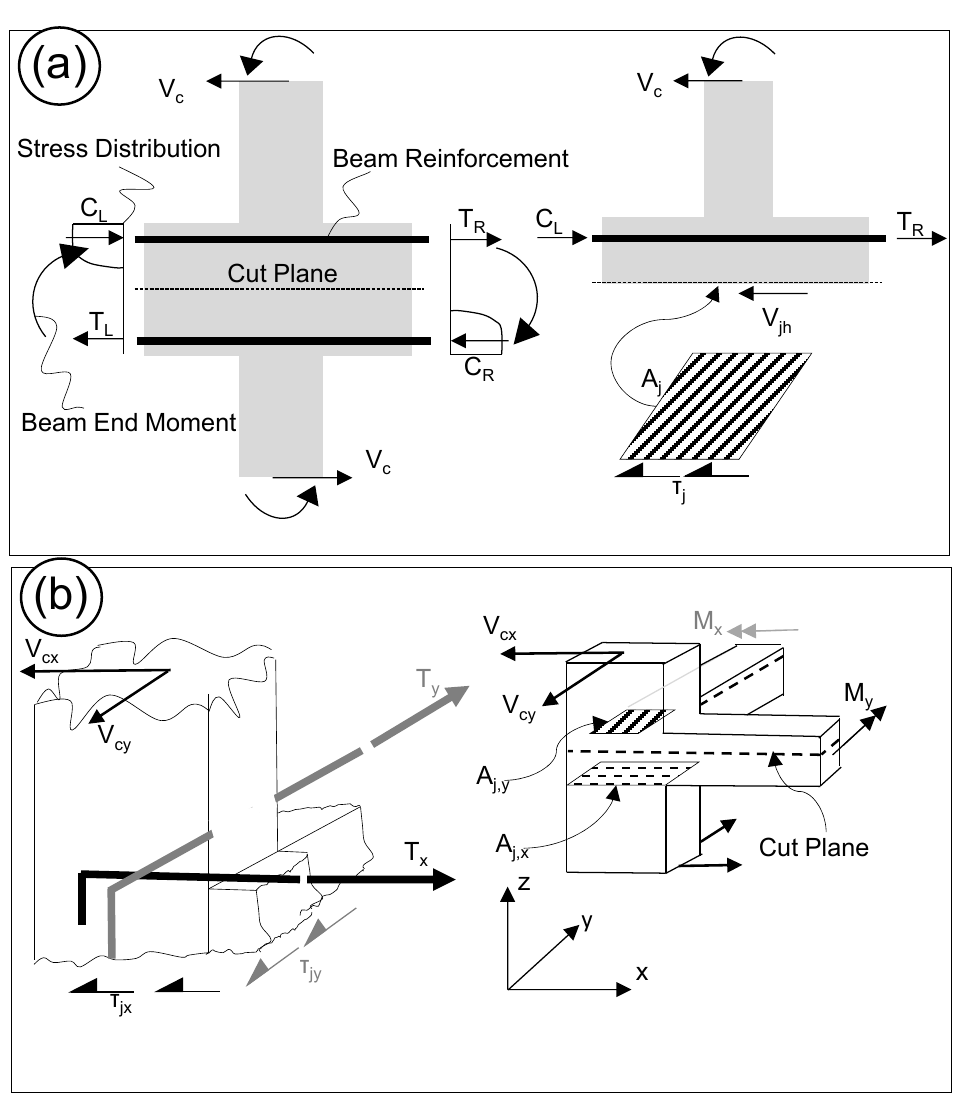
Figure 2. Horizontal joint shear ( V jh ) definition: ( a ) Case of a 2D interior joint; ( b ) 3D corner